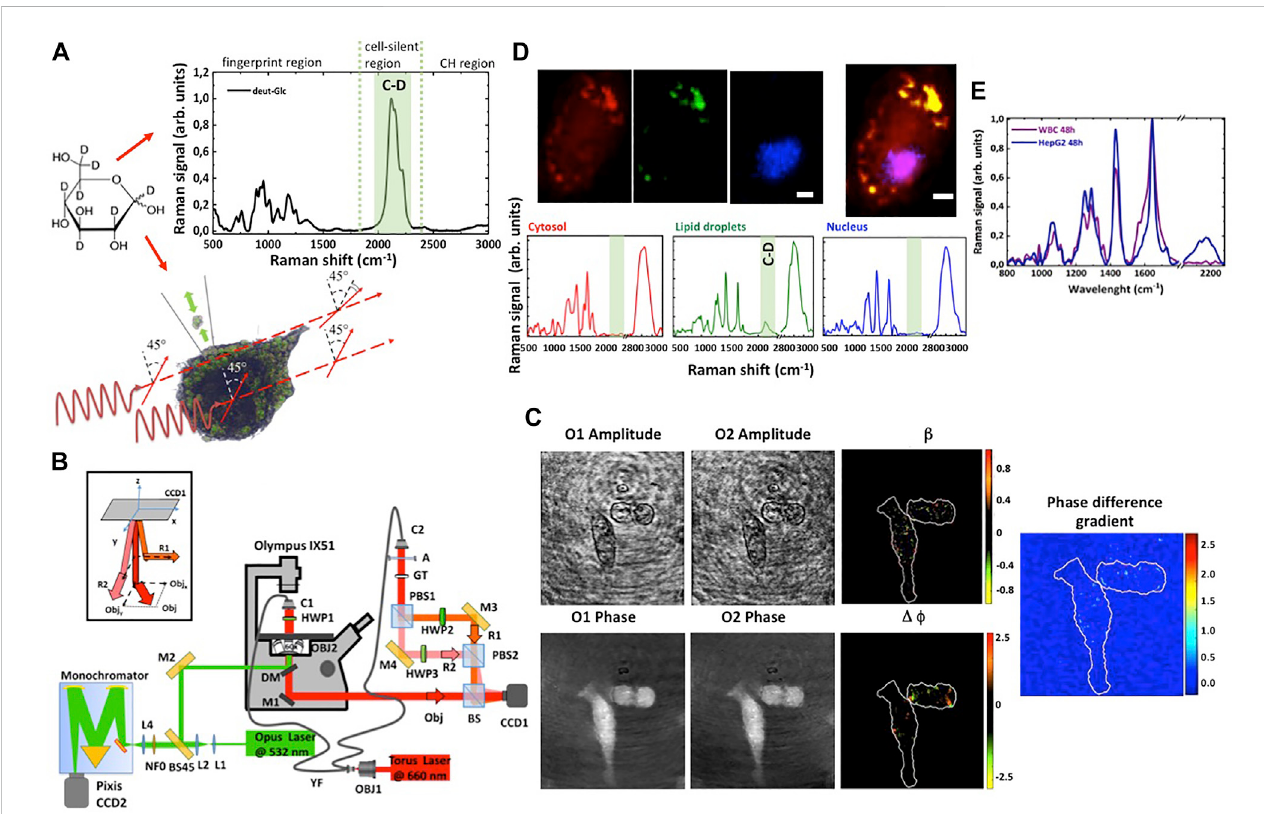
FIGURE 1 Schematic for the combined imaging by Raman microscopy and polarization sensitive digital holography. (A) The Raman spectrum of the isotope labelled glucose (deut-Glc) at 1 M in aqueous solution revealed a Raman band around ~2,120 cm − 1 . The C-D signal can be used as tracer to visualize the glucoseuptakeandlipiddropletsformationincancercells.Achangeinthepolarizationofthelightisobservedonlyincorrespondenceoflipiddroplets,dueto optical rotatory dispersion of these micro-structures. (B) Combined experimental setup. (C) Reconstructed amplitude and phase maps for the two orthogonal components of the object fi eld and the corresponding amplitude ratio and phase difference maps. The gradient of the phase difference map is reported on the right. The bright spots correspond to strong birefringence variations. Scale bar: 10 μ m. (D) A representative Raman image of HepG2 cells incubated with deut-Glc. The cytosol is represented in red, the lipid droplets in green and the nucleus in blue. Below, the representative spectra of cytosol, lipid droplets and nucleus. The deuterium signal at 2,120 cm − 1 is strongly visible in the lipid droplets spectrum. Scale bare: 5 μ m. (E) Raman spectra of cancer cells (blue line) cells co-cultured with WBCs (purple line). For WBCs, the C-D signal around 2,120 cm − 1 is completely